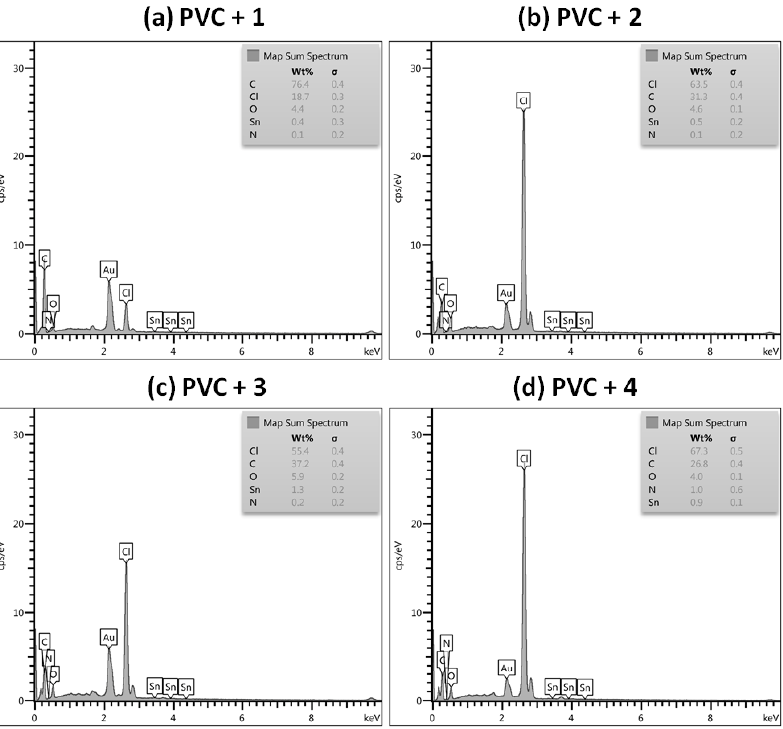
Figure 1. Energy-Dispersive X-Ray (EDX) patterns for poly(vinyl chloride) (PVC) films: ( a ) PVC + 1 , ( b ) PVC + 2 , ( c ) PVC + 3 , and ( d ) PVC + 4 . The EDX mapping of PVC films containing additives show the distribution and relative abundance of elements within the blends (Figure 2) [46]. Clearly, the images indicate the homogenous distribution of the elements from both tin complexes and PVC. Chlorine and carbon atoms are highly abundant and distributed thought the blends. In addition, the images indicate the presence of other elements (tin, nitrogen, and oxygen) within the complexes.